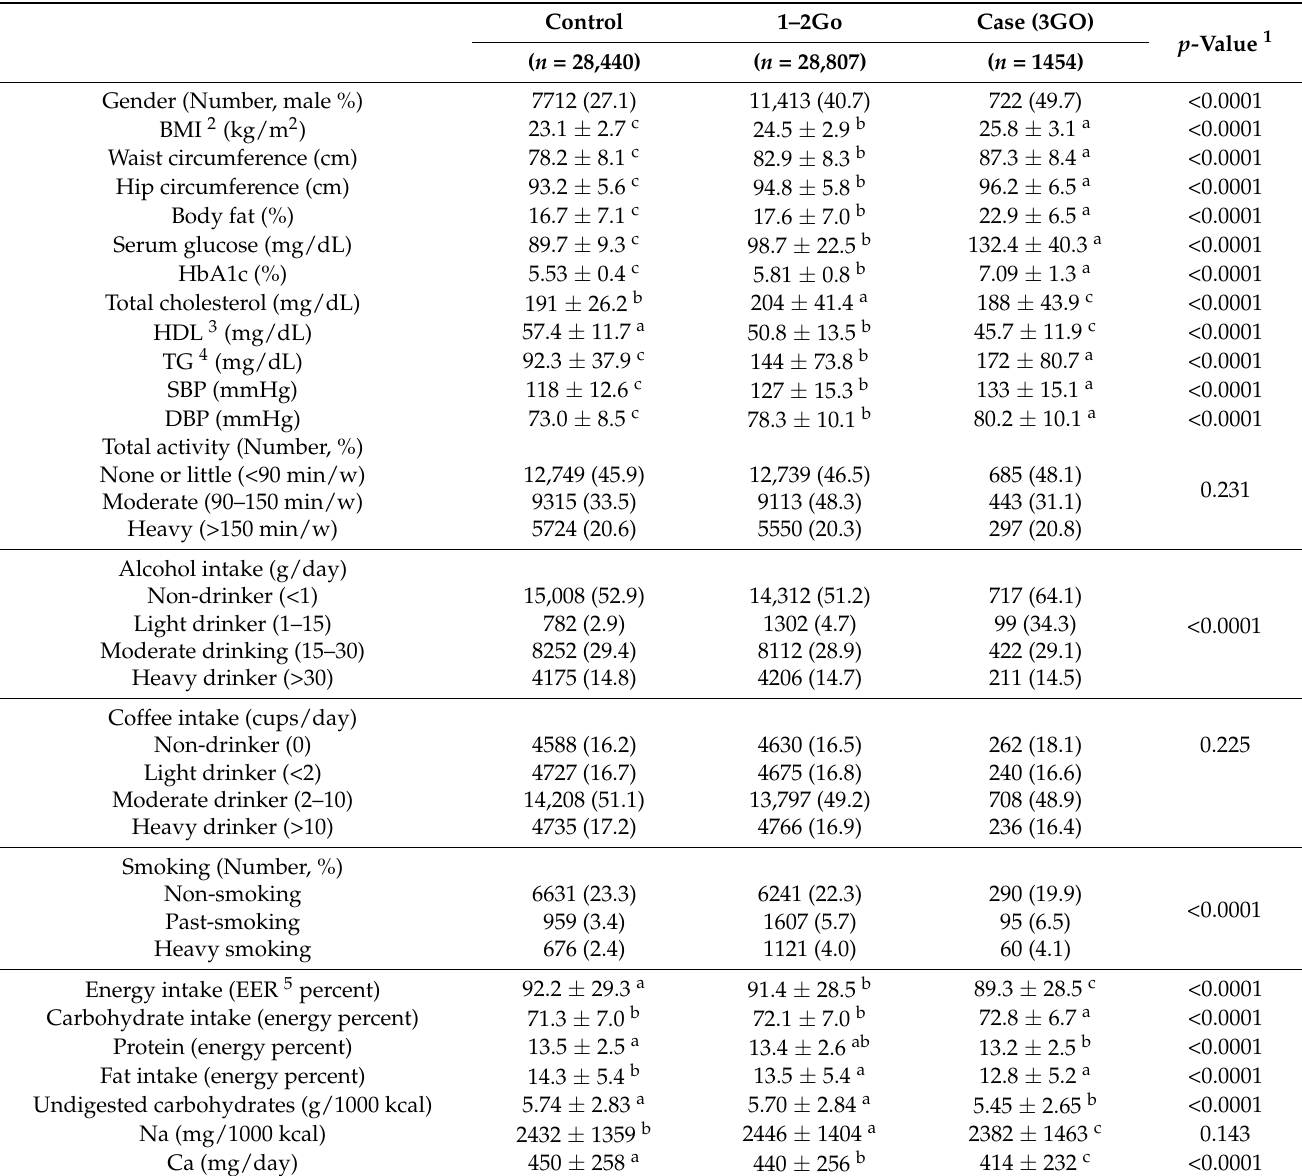
Table 1. General characteristics of the study population according to